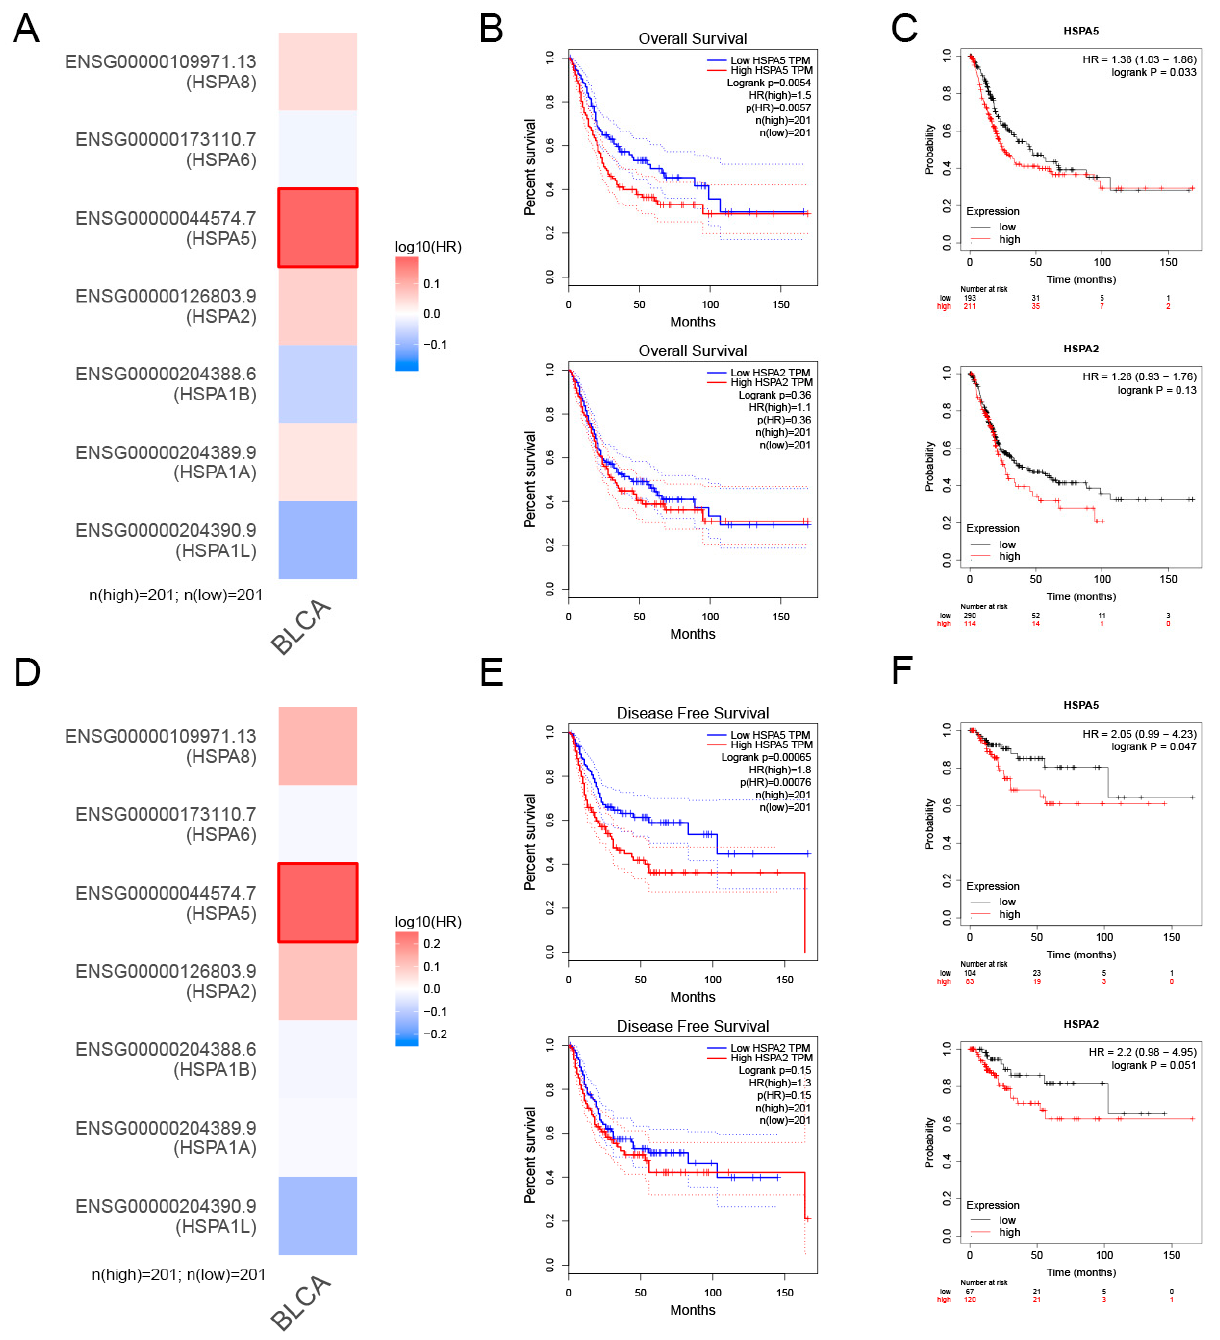
Figure 2. Correlation between HSPA2 or HSPA5 expression and patient survival. ( A ) The relationship between the expression levels of HSPA2 or HSPA5 with patient overall survival from the TCGA heatmap. ( B , C ) Analysis of overall survival from GEPIA (http://gepia.cancer-pku.cn/) (accessed